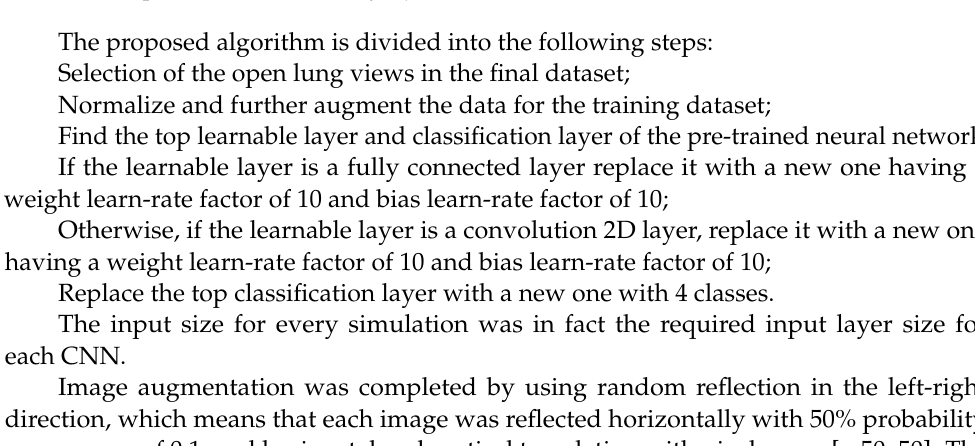
Figure 4. Samples of frames manually rejected from the dataset. Table 2. Training options.